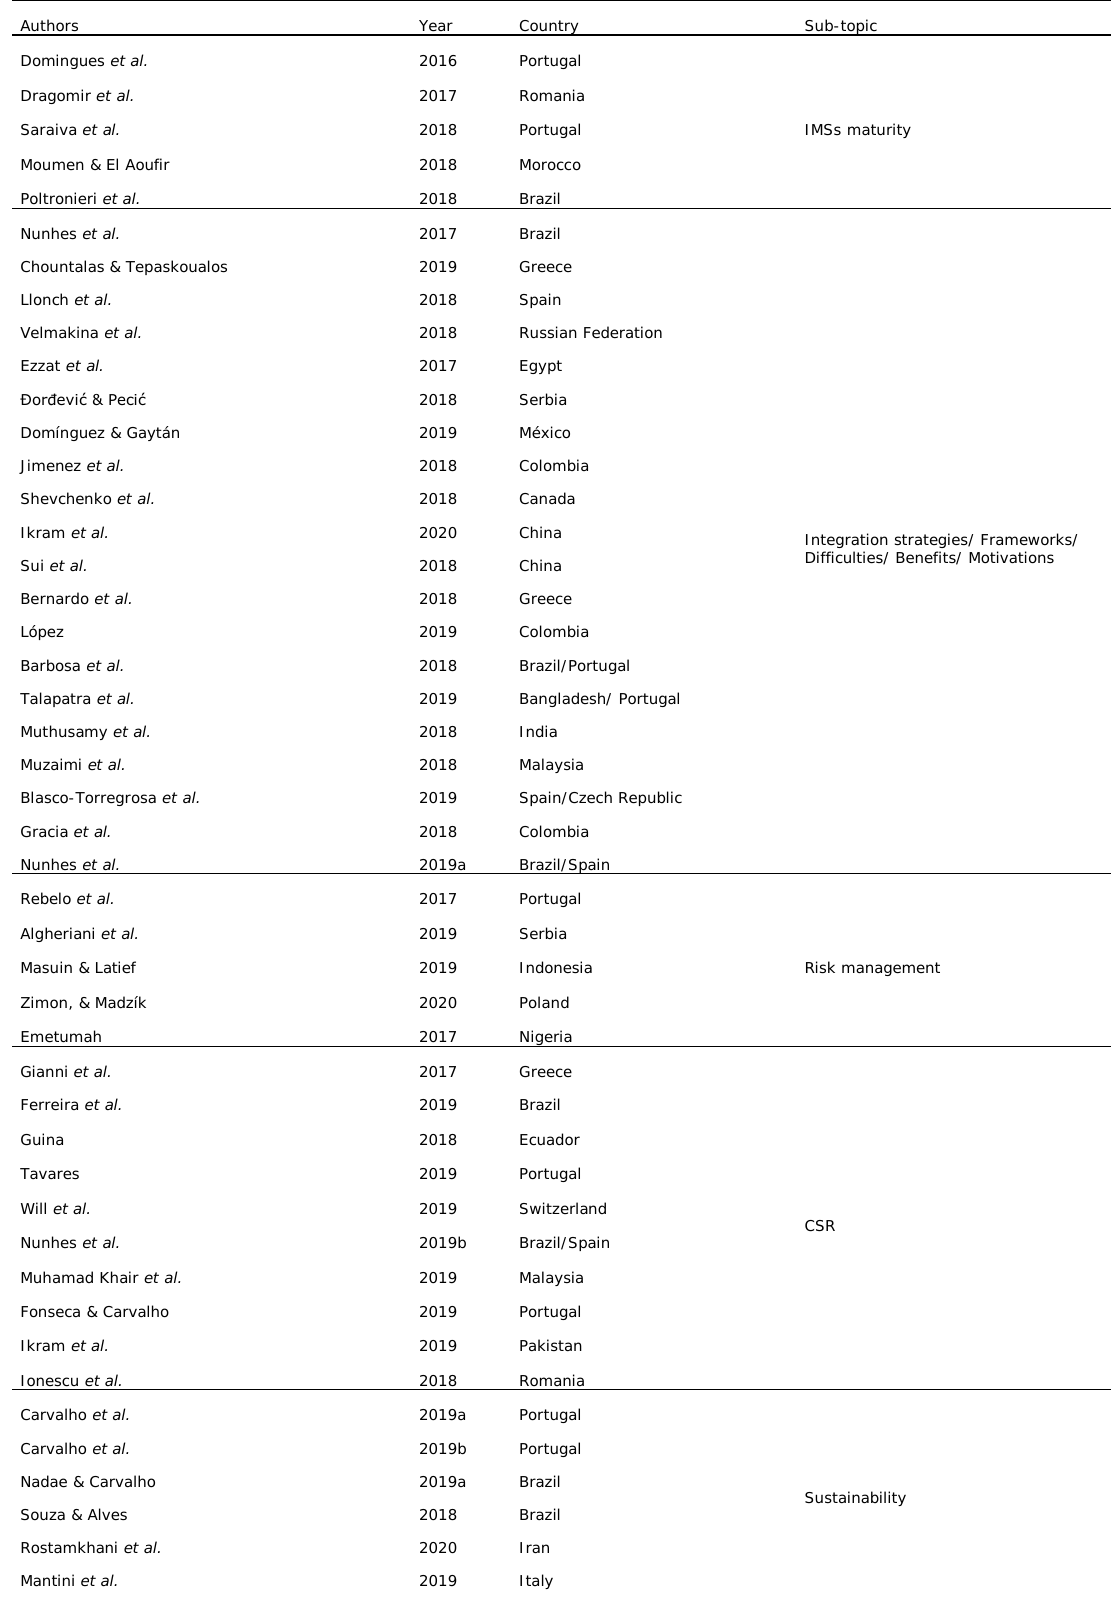
Table A1. Latest published studies in the domain of